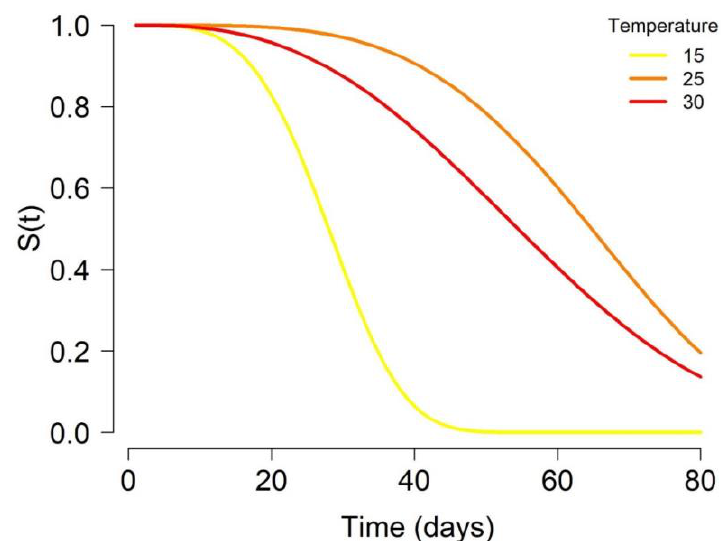
Figure 2. Survival rate of Ae. albopictus females adjusted to the Weibull’s model at temperatures of 15, 25, and 30 °C.